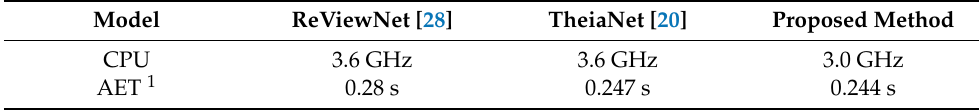
Table 8. Comparison of average execution time per frame on CPU.